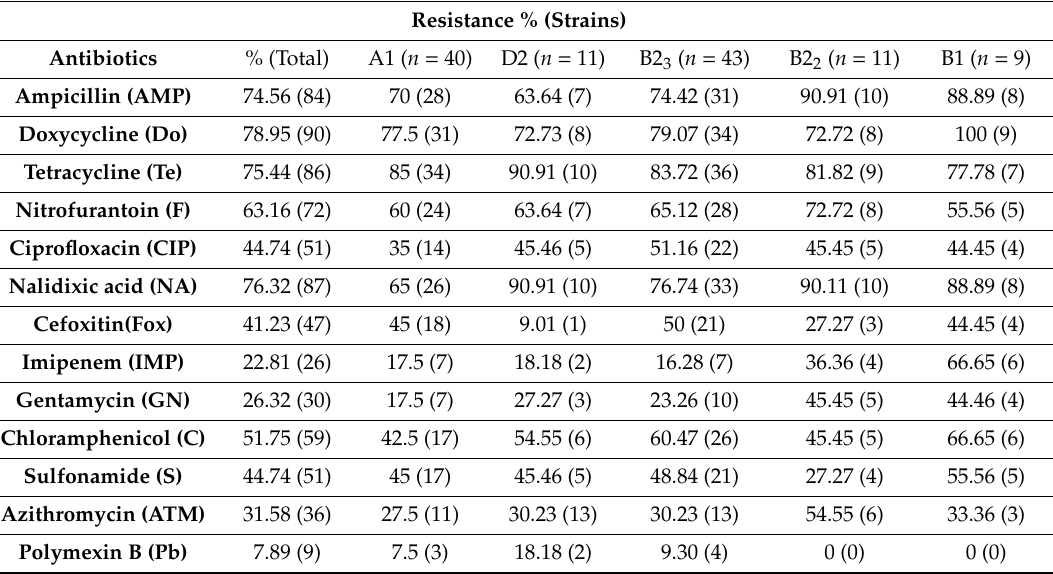
Table 1. Relationship between APEC phylotypes and drug